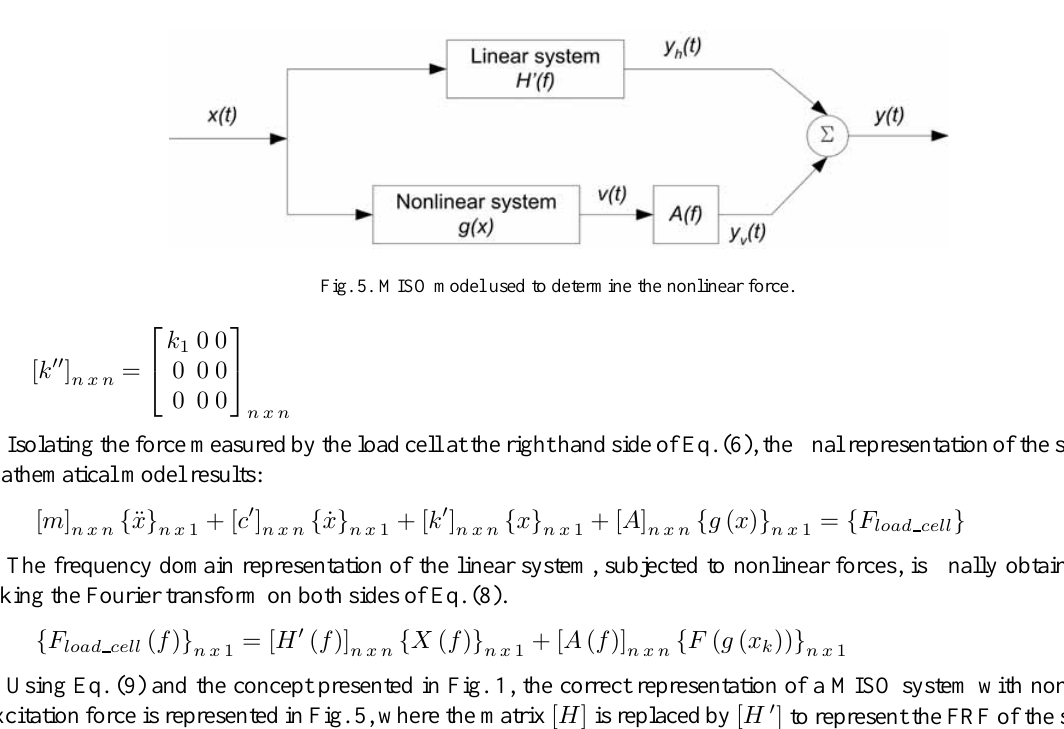
Fig. 4. Linear system subjected to a nonlinear force.